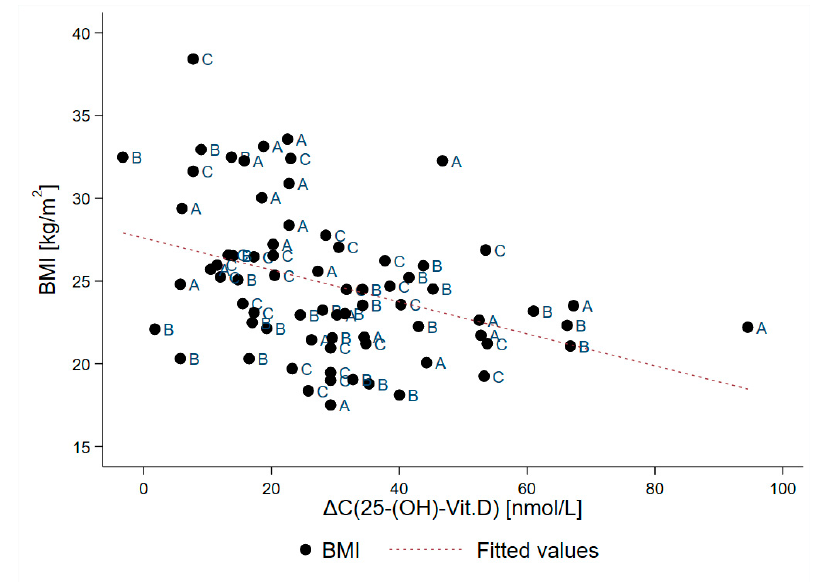
Figure 5. Pearson linear correlation of the treatment-related increase in serum 25-OH-VitD concentration (Δc; nmol/L) and body mass index (BMI; kg/m 2 ) for subjects in all three treatment groups (A + B + C; N = 73; missing BMI value for one subject). A — capsules; B — oil-based spray; and C — water-based spray.